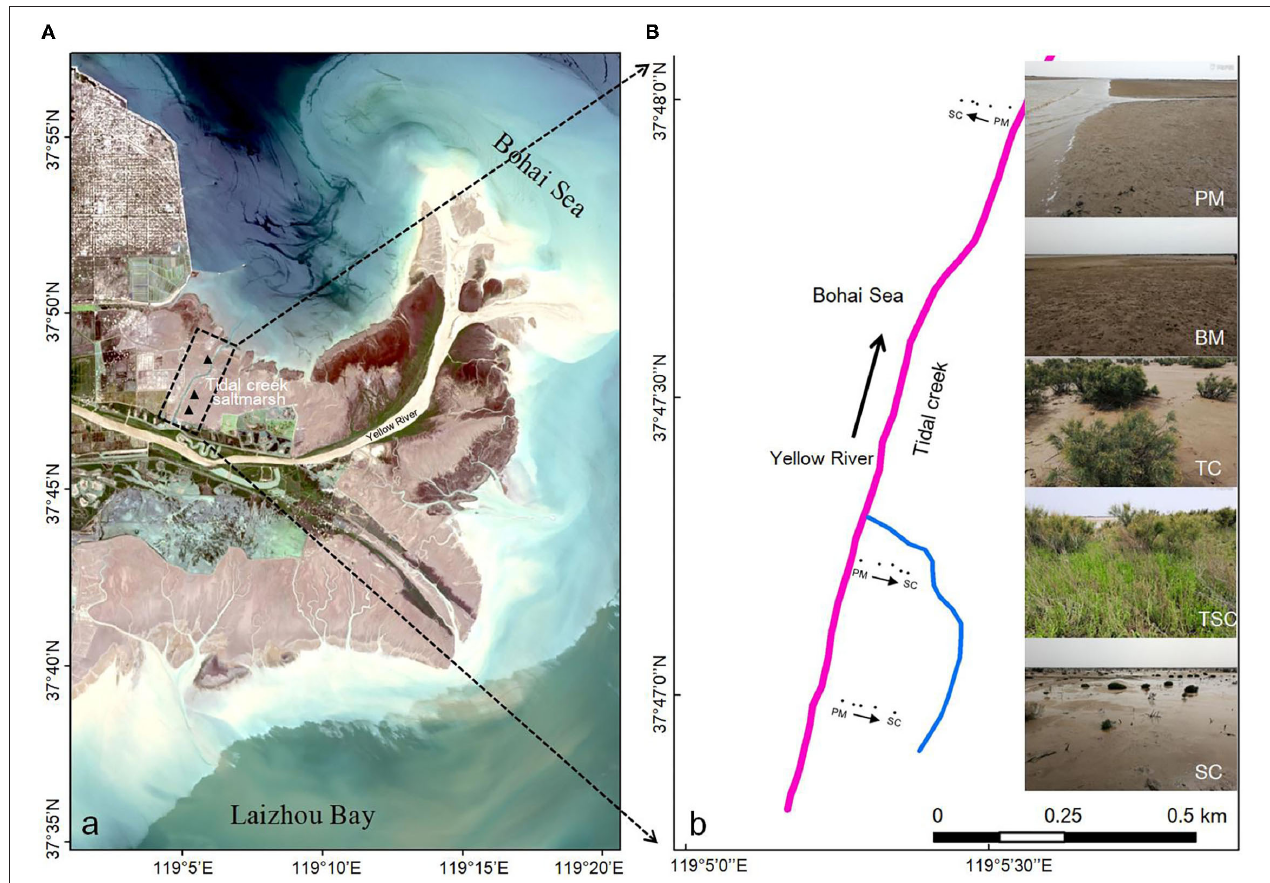
FIGURE 1 | (A) Location of the micro-habitats around the tidal creek in the Yellow River estuary wetland. (B) Landforms of the micro-habitats around the tidal creek, namely PM (pluff mudflat), BM (bare mudflat), TC ( Tamarix chinensis community), TSC ( T. chinensis and Suaeda salsa community), and SC ( S. salsa